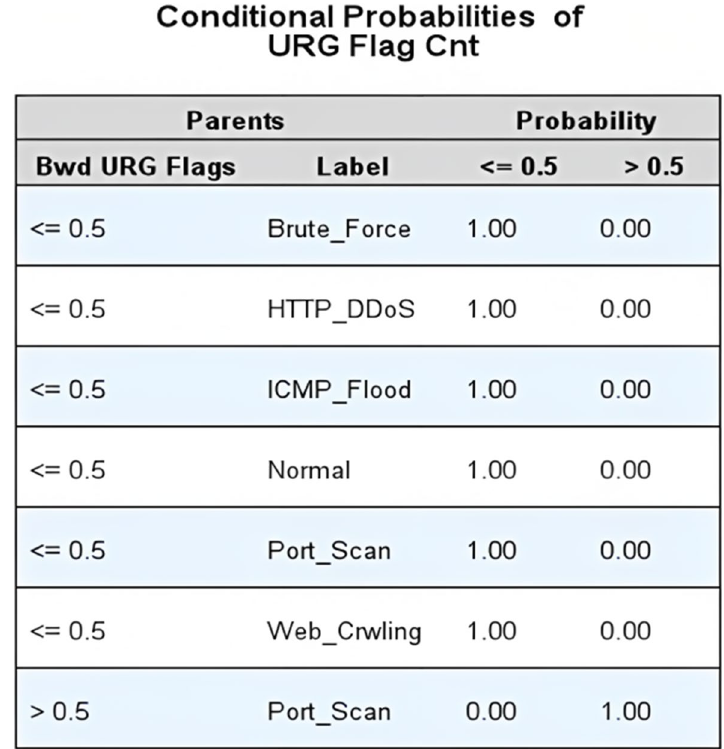
Fig. 5 Conditional probabilities of URG flag Cnt input variable